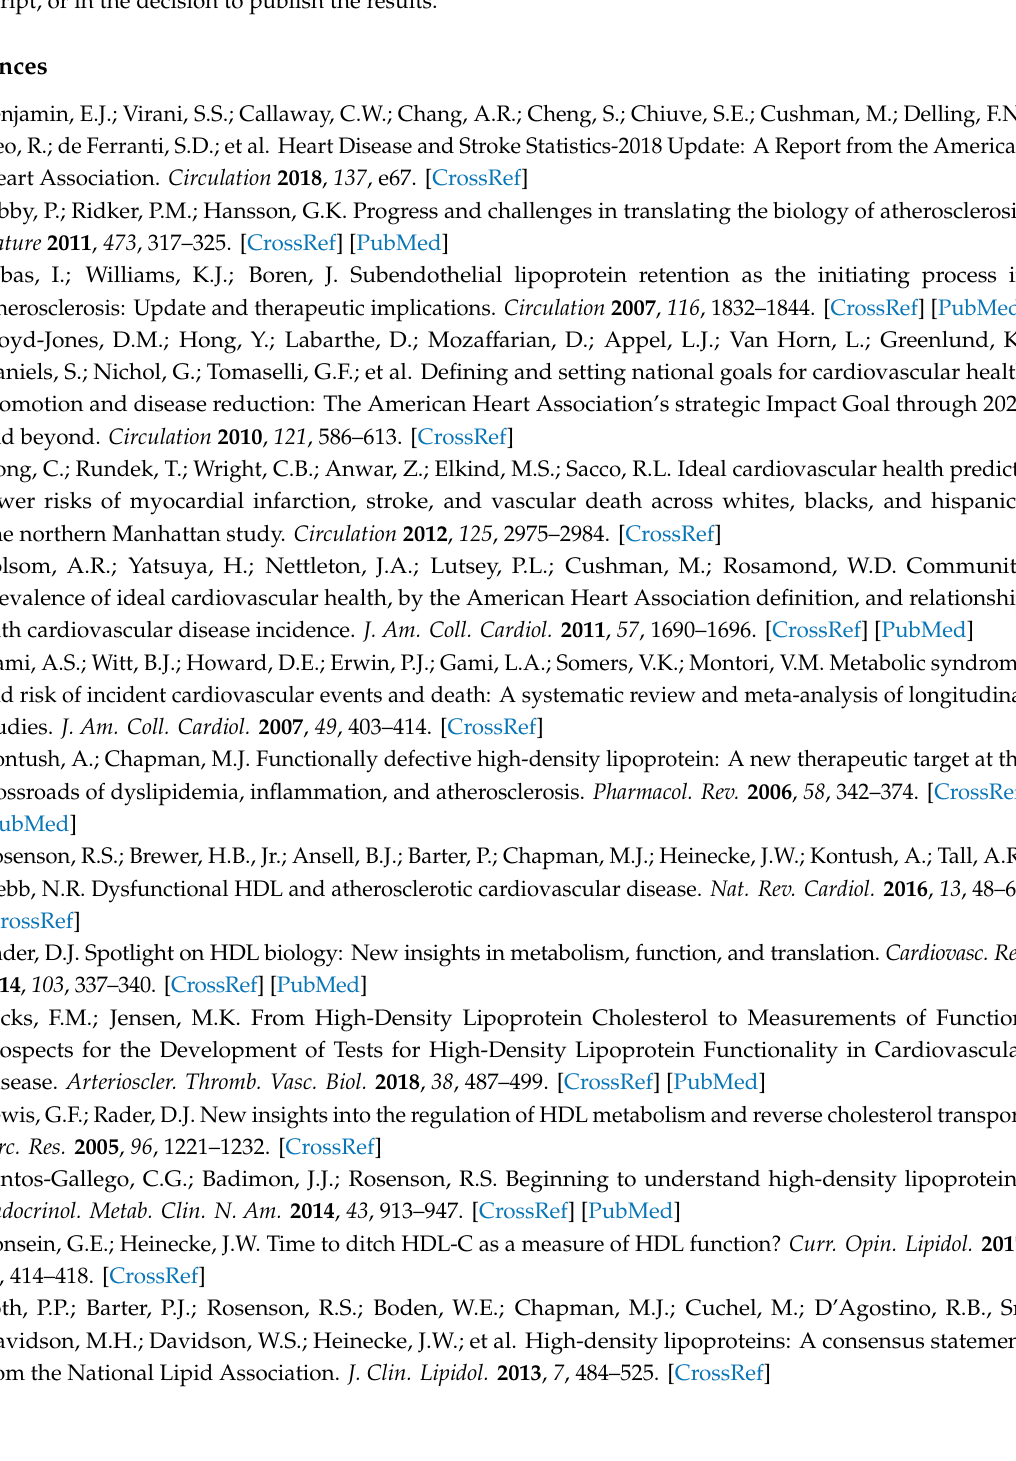
a ff ects HDL functional parameters and other cardiovascular health biomarkers, recommendations for healthful dietary patterns can be made with more confidence. Table S1: HDL concentration, HDL-related Functional Parameters and Mediterranean